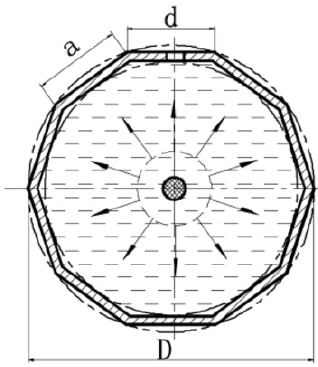
Figure 1. Geometrical illustration of the problem.